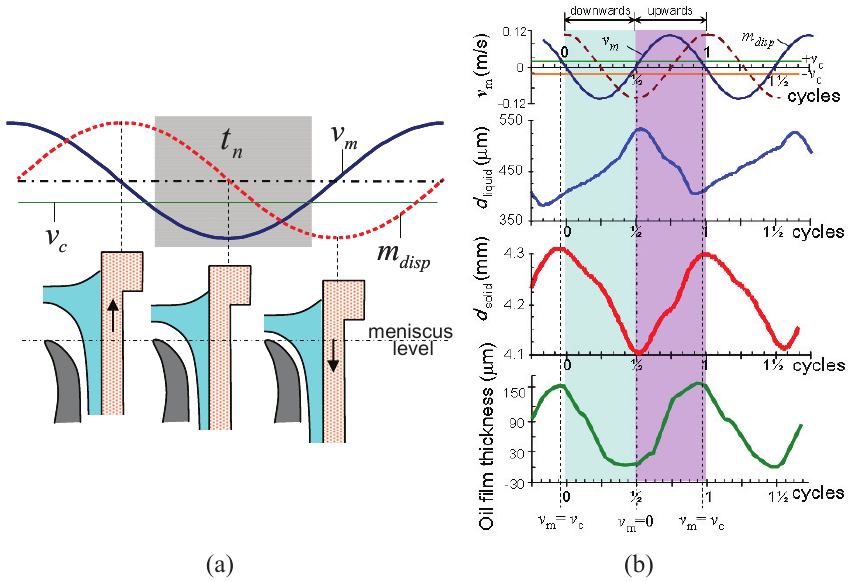
Figure 7. (a) Schematic drawing showing effect of mould oscillation; line D mould velocity ( V m ) dotted line D mould displacement and (b) thicknesses of liquid ( d liquid ) solid ( d solid ) slag films and oil layer ( d oil ) (Kajitani et al. [14]).